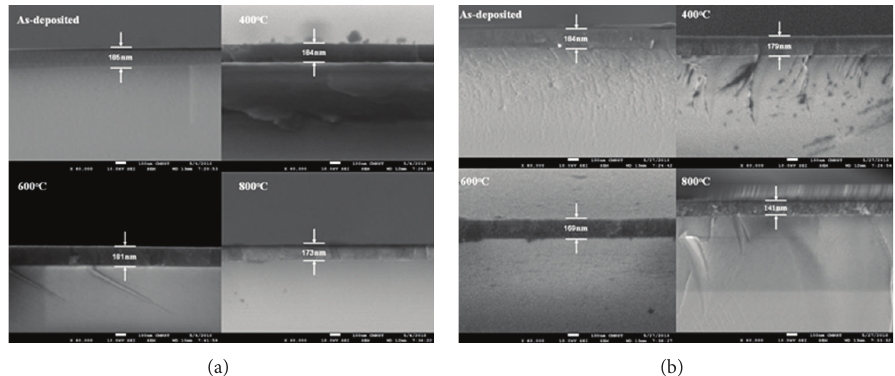
Figure 3: Cross-sectional view by SEM of the TiO 2 films from (a) Ti 3 O 5 and (b) TiO 2 starting materials annealed at 400 ∘ C, 600 ∘ C, and 800 ∘